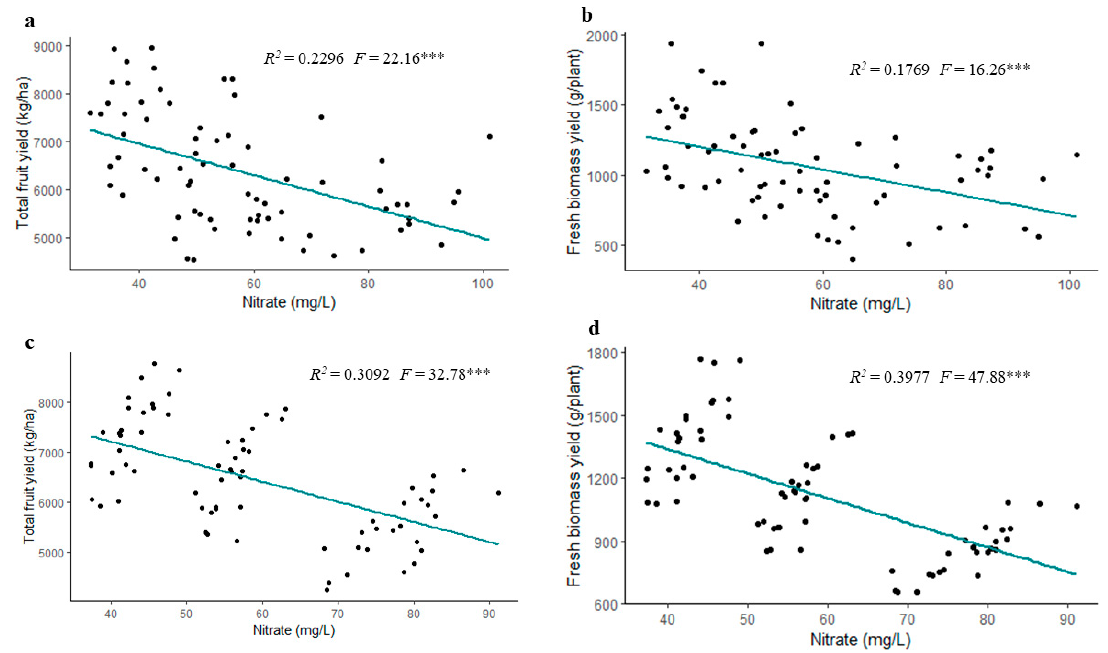
Figure 6 . Regression plots showing the linear relationship between total fruit yield (fresh weight) and nitrate accumulation in squash fruits in ( a ) 2020 and ( c ) 2021 and between fresh biomass yield and nitrate accumulation in squash fruits in ( b ) 2020 and ( d ) 2021 . R 2 , regression coefficient of de- and nitrate accumulation in squash fruits in ( b ) 2020 and ( d ) 2021. R 2 , regression coefficient of termination; F, calculated F-statistic value; ***, significant at p ≤ 0.001. determination; F, calculated F-statistic value; ***, significant at p ≤